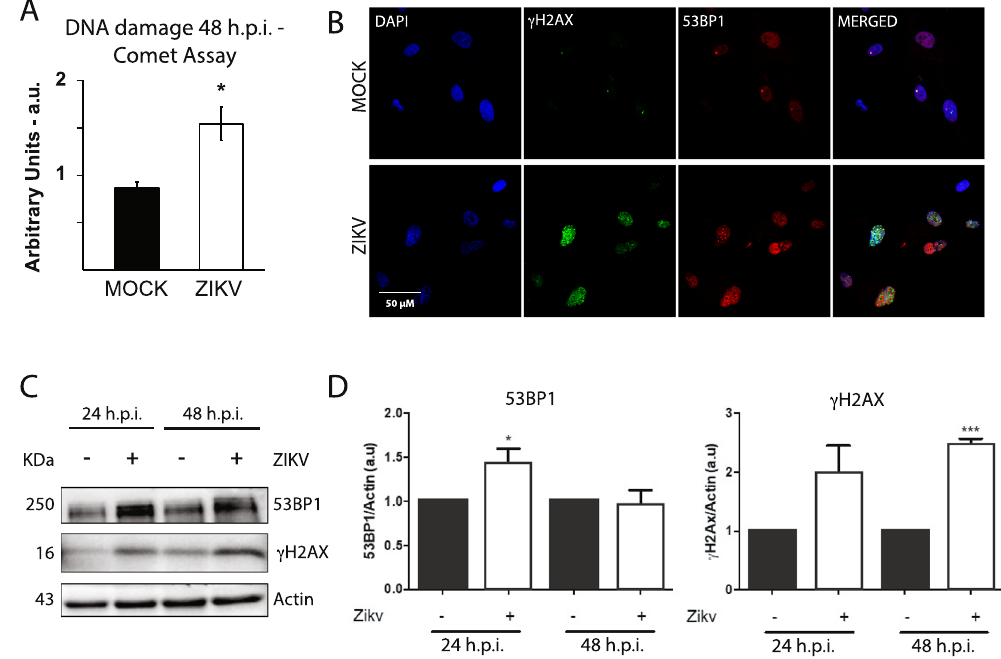
Figure 4. ZIKV-induced DNA damage. ( A ) Alkaline comet assay shows an increase in DNA damage in ZIKV- infected astrocytes when compared to MOCK. N = 4. ( B ) γ H2AX and 53BP1 immunostaining in MOCK- and ZIKV-infected astrocytes, 48 h.p.i.. DAPI for nuclei staining is shown in blue, γ H2AX is shown in green, and 53BP1 is shown in red. Merged images are shown at the right. Scale bar: 50 µ m. Quantification of images is shown on Fig. 5C. ( C ) Western blotting (WB) analysis of γ H2AX and 53BP1 in MOCK and ZIKV-infected astrocytes at 24 and 48 hpi, MOI = 1. ( D ) Protein levels were quantified related to actin expression levels. N = 3. * p < 0.05, *** p <